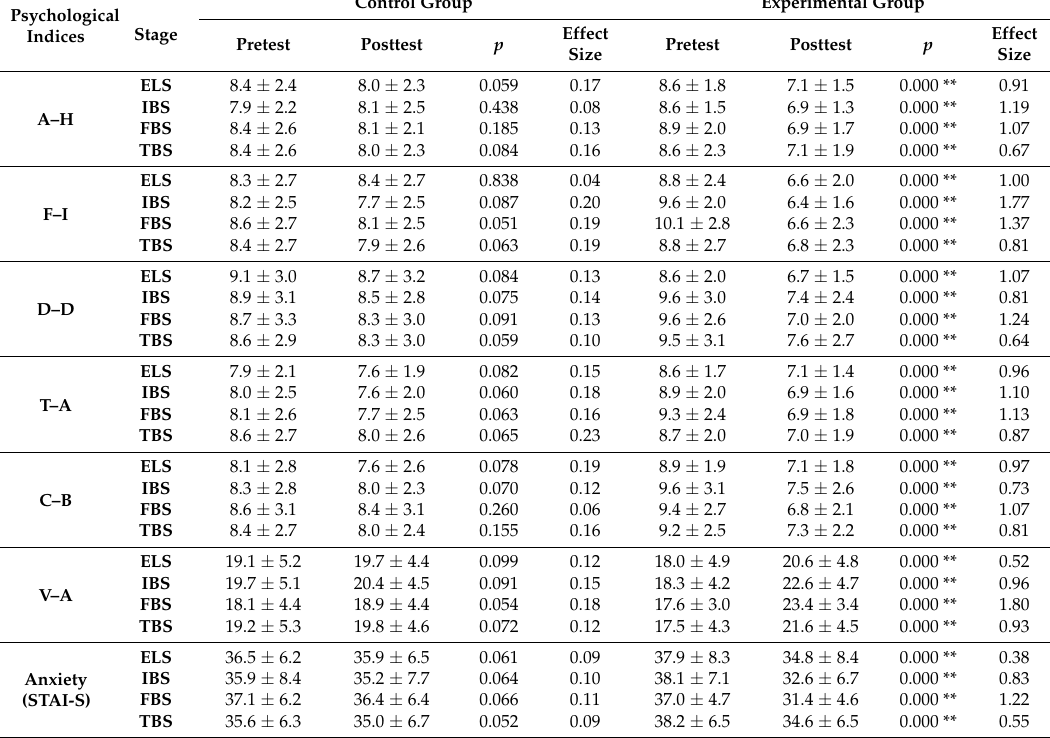
Table 3. The pre- and post-measurement variable values of participants’ psychological indices in the control and experimental groups across four stages.